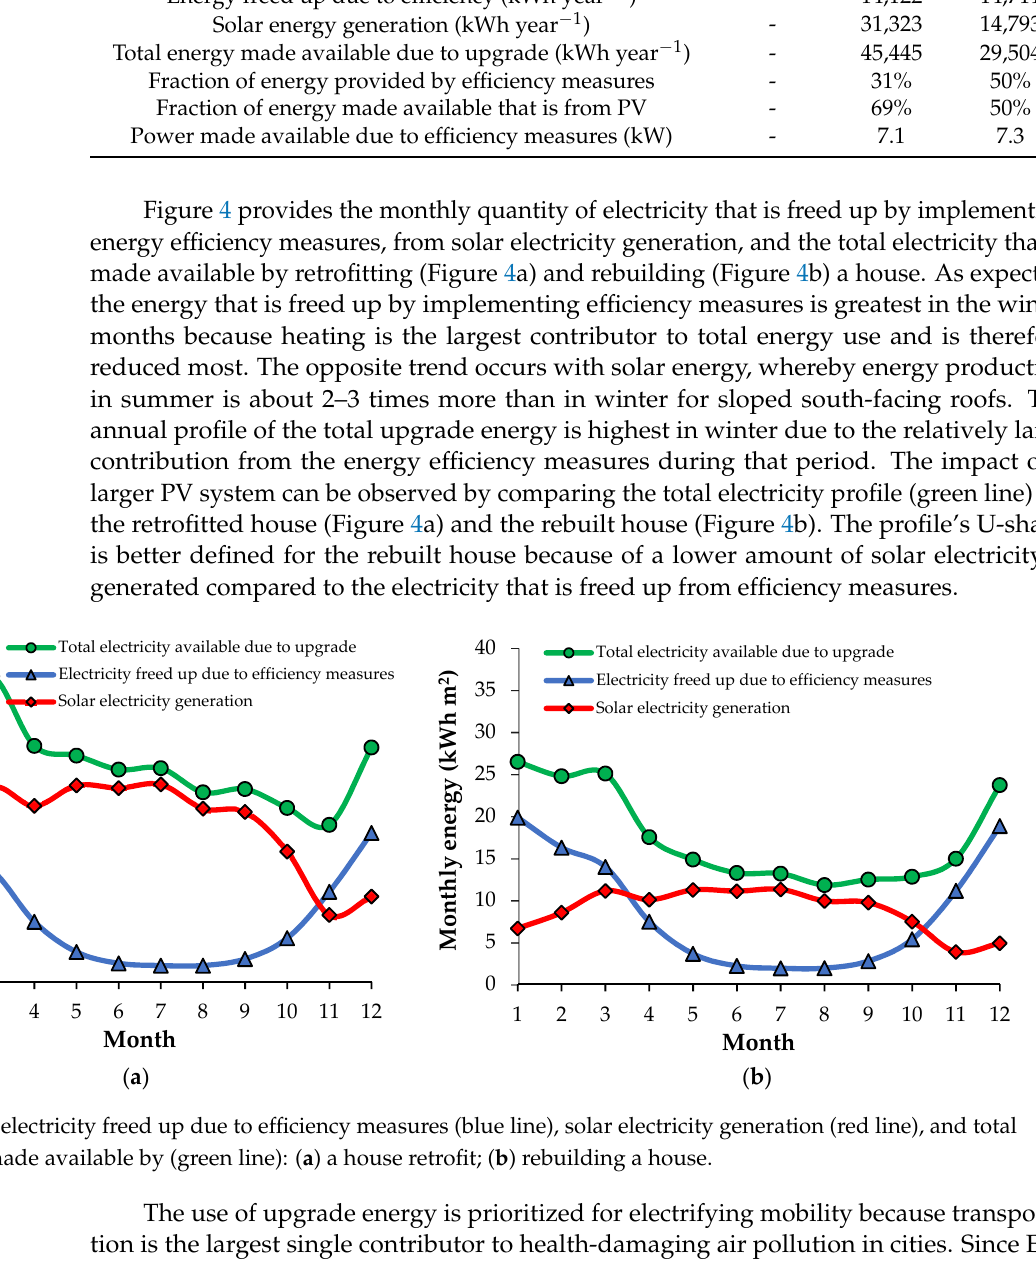
Figure 5. Generic energy profile produced by upgrading to a low-energy solar building showing the portions available for mobility and heating decarbonization. It should be noted that the energy consumption of an existing house is representa- tive of a recently built house. More energy would be freed up by implementing energy efficiency measures if older, less efficient houses are selected for the analysis. Therefore, this paper provides conservative estimates that are more representative of what could be expected in the future, when recently built houses will be renovated or rebuilt. Addi- tionally, a portion of solar energy generation would usually be consumed on-site (self-consumption) to minimize energy transactions with the grid and peak demand. Although it is assumed they would be implemented, these grid-interactive flexibility and self-consumption strategies were not considered in the analysis as they would not sig- nificantly impact the quantity of house upgrade energy. In addition, separating them